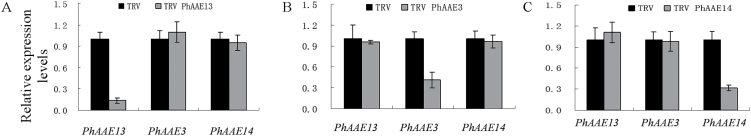
Effects of (A) TRV-PhAAE13, (B) TRV-PhAAE3, and (C) TRV-PhAAE14 treatment on the expression of PhAAE13, PhAAE3, and PhAAE14 in flowers at anthesis as determined by qPCR. Relative expression levels are shown as fold-change values. Data are presented as means±SD (n=3).